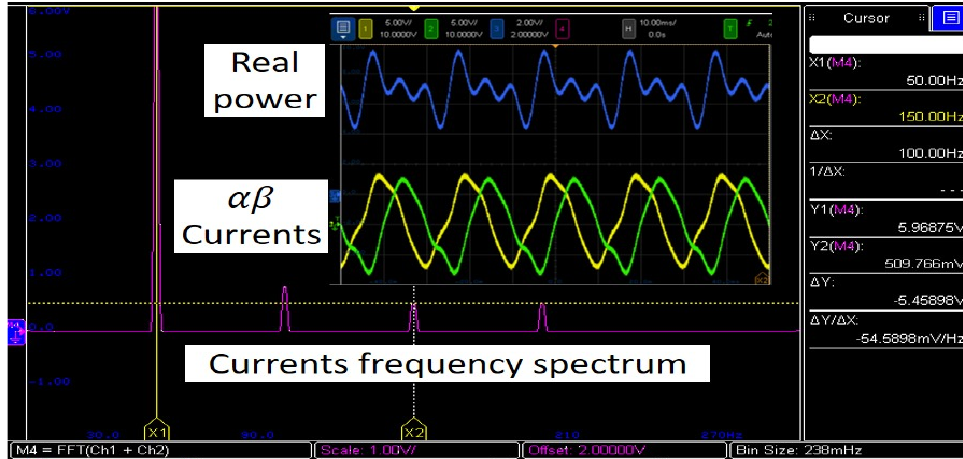
Figure 4. Power and αβ currents delivered by the PCC without